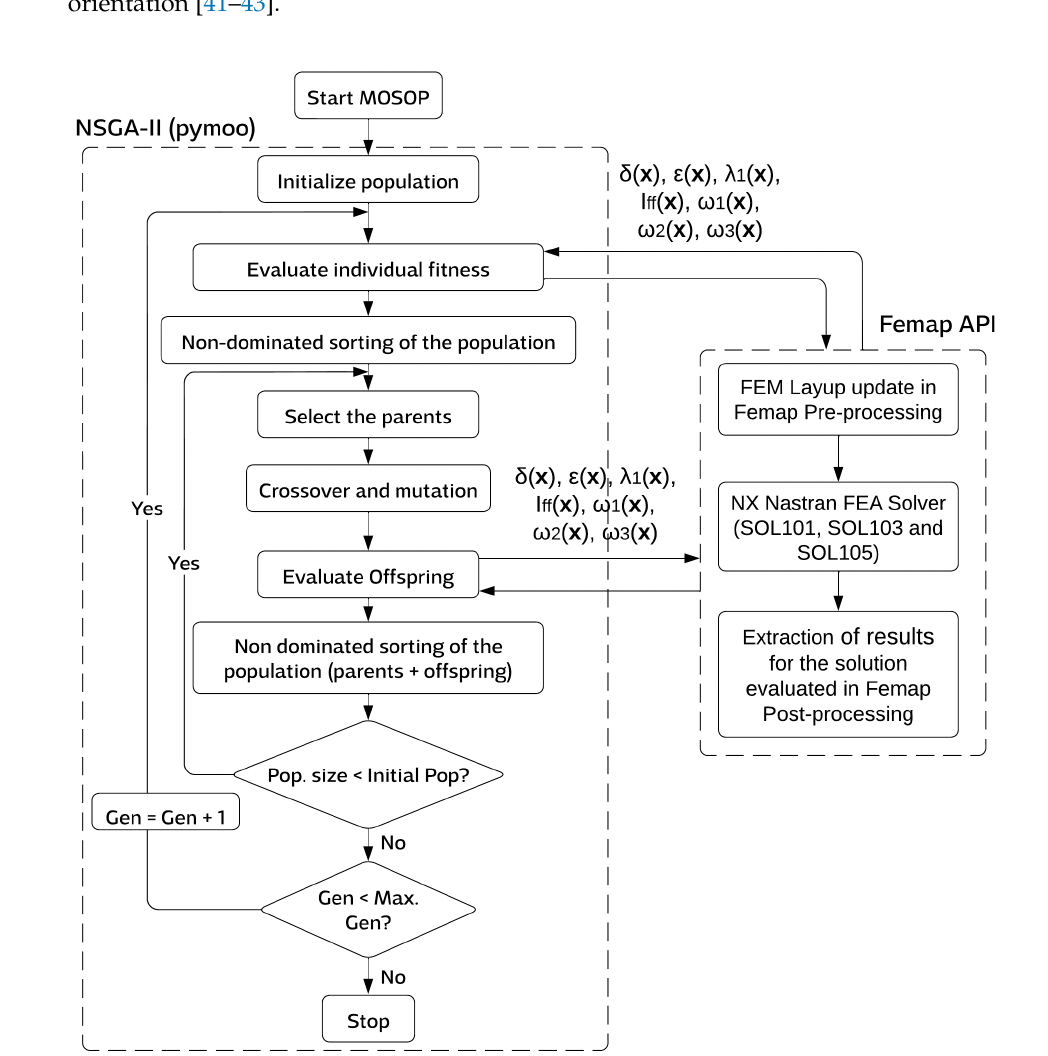
Figure 1. The optimization flowchart combining NSGA-II algorithm with finite element method.